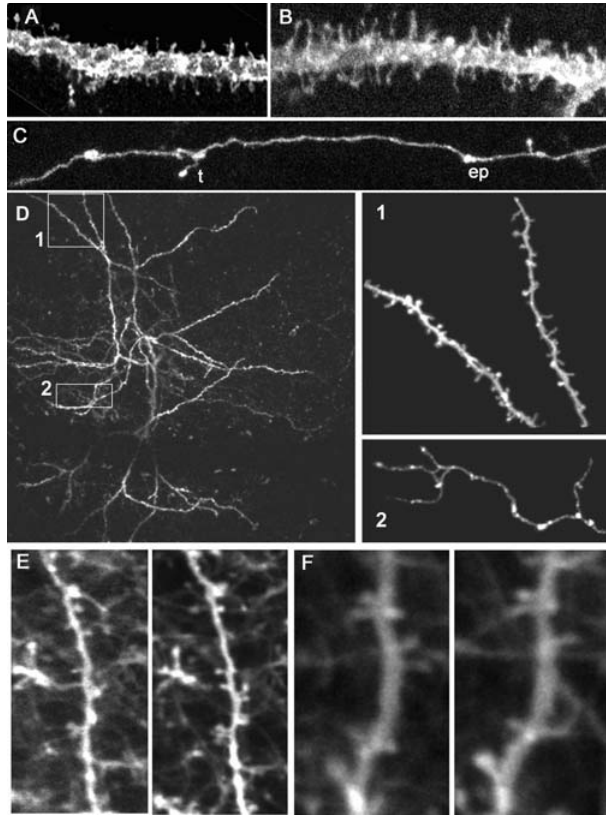
Figure 6. Membrane expression of EGFP-F labels dendritic spines and axonal boutons (A–C) Detailed confocal microscopy images show that the farnesylation site on EGFP-F targets its expression predominantly to the membrane surface in TLG 1157 + Cre 3487 + mice. EGFP-F labels large and small dendritic spines. (C) Terminaux (t) and en passant (ep) axonal boutons are clearly labeled by EGFP-F. (D) Z- projection of a stack acquired by in vivo two photon imaging of the visual cortex of a ten week old TLG 498 + Cre 3487 + transgenic animal. The collapsed image shows dendrites of two neighboring layer V pyramidal neurons, 75–100 m m from the pial surface. Dendritic protrusions (D1) and axonal boutons (D2) are clearly visible. (E–F) Z- projections of stacks acquired by chronic in vivo two photon imaging of the visual cortex of a 4 month old TLG 1157 + Cre 3487 + transgenic animal. Dendrites with dendritic spines of different pyramidal neurons imaged 7 and 9 days (E) and 12 and 15 days (F) after window implantation, 75–100 m m from the pial